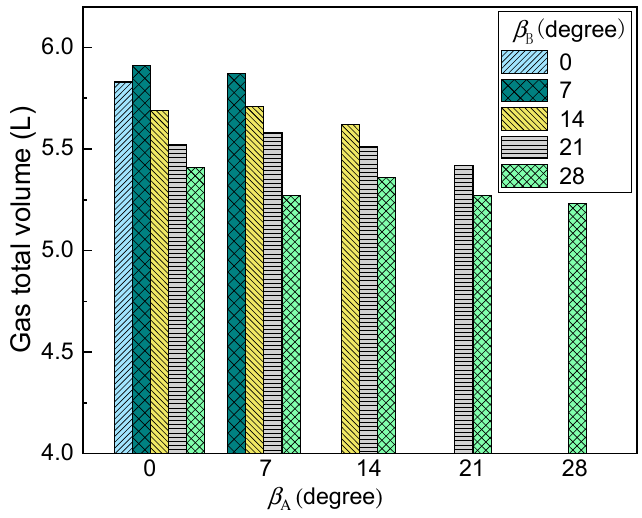
ff ect of di ff erent nozzle arrangement on the predicted gas total volume in the Figure 9. Effect of different nozzle arrangement on the predicted gas total volume in the bath. Figure 9. E